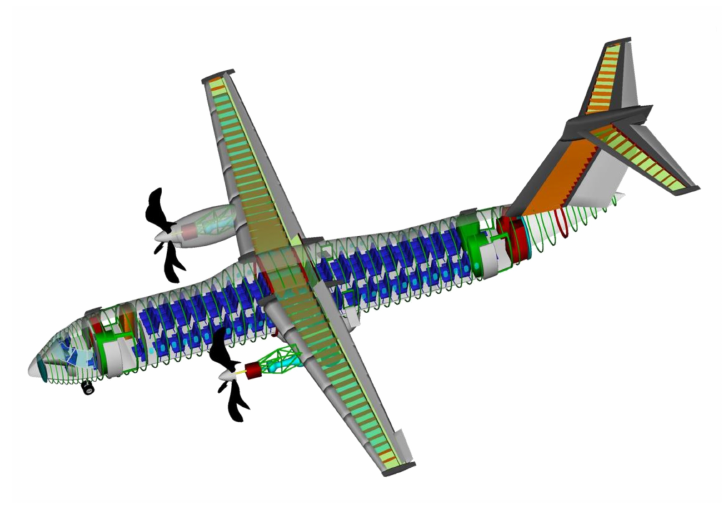
Figure 1. SFB880 reference aircraft with novel high lift system.